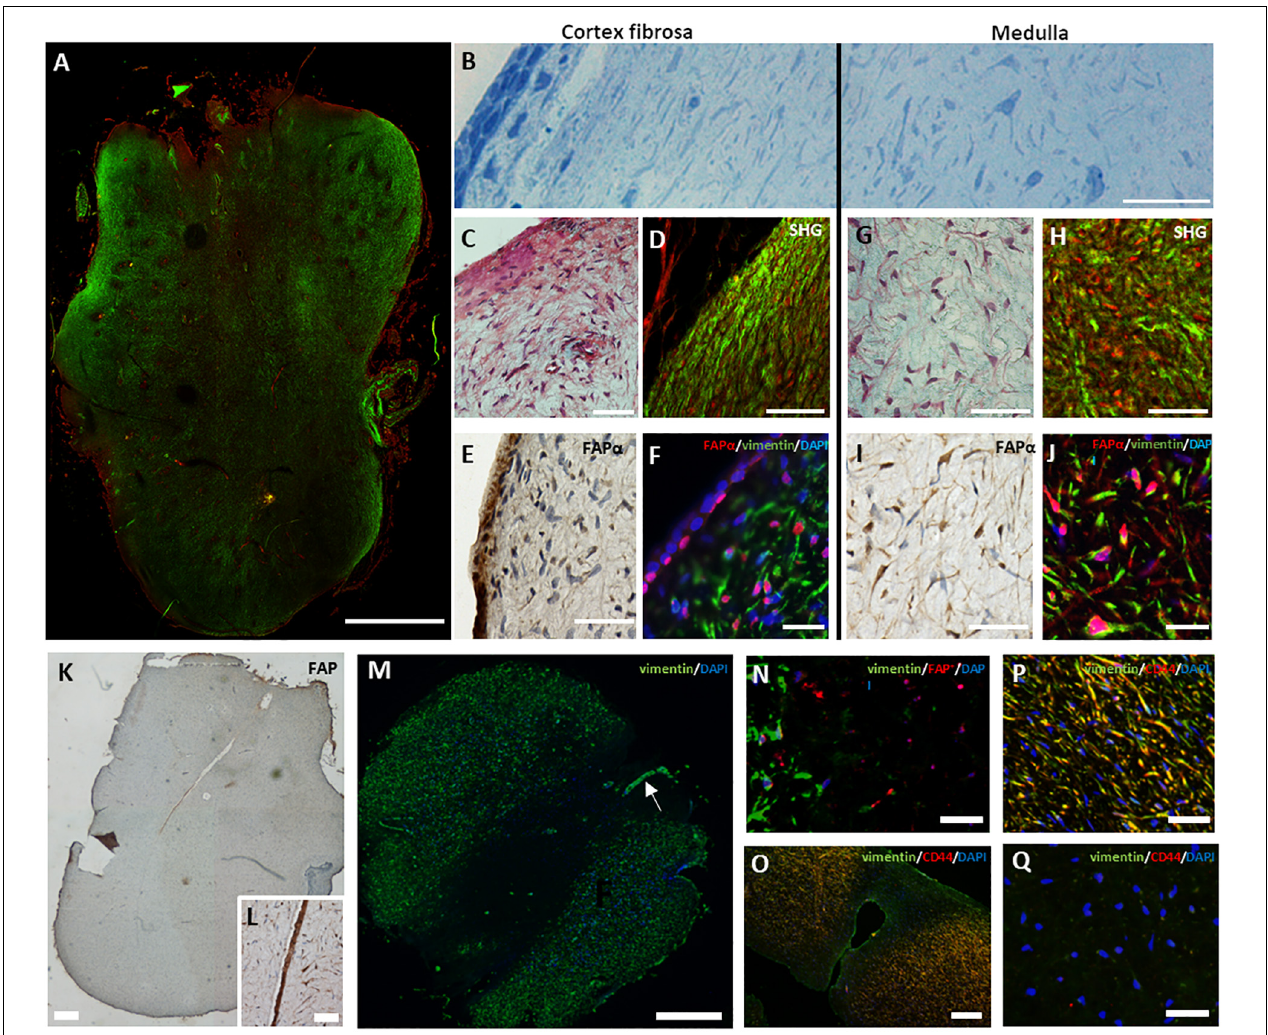
FIGURE 2 | Heterogeneous expression of FAP α in the apical papilla. (A) Tile scan of a second harmonic generated overview of a complete apical papilla (green, collagen type I; red, autofluorescence). (B) Semi-thin section of an apical papilla stained with toluidine blue showing a parallel orientation of cells at the cortex fibrosa but random orientation inside the medulla. (C) Masson’s Trichrome staining of the cortex fibrosa showing a high collagen concentration. (D) Second harmonic generation imaging of the periphery of the apical papilla (green, collagen type I; red, autofluorescence). (E) DAB staining for FAP α reveals a heterogeneous expression pattern at the periphery of the tissue. Note the marked staining of FAP α in the epithelial region. (F) Double immunofluorescent staining showing predominantly vimentin positive cells (green) and a small population of FAP α + (red)/vimentin + cells. The epithelial region consists of FAP α + but vimentin − cells. (G) Masson’s Trichrome staining of the medulla reveals a loose extracellular matrix with spindle-shaped cells. (H) Second harmonic imaging confirms the loose collagen distribution (green). (I) DAB staining indicates high expression levels of FAP α in the medulla. (J) Immunofluorescent staining reveals a predominant population of FAP α + (red)/vimentin + (green) cells. (K) FAP α expression in the dental nerve ( K , magnification in L ). (M) Immunofluorescent staining showing absence of vimentin staining in the inner medulla. Note the presence of the vimentin positive nerve ( M , arrow). (N) Double immunofluorescent staining showing vimentin negative but FAP α positive cells (red) in the inner medulla. (O–Q) Double immunofluorescent staining of vimentin (green) and CD44 (red) reveals double positive cells in the outer medulla (yellow) but complete absence of staining in the inner medulla. Scale bars represent 25 (F,J,O,P,Q,N) , 50 (B,C,D,E,G,H,I,L) , 100 (J) , 250 (K,M) , and 1000 (A) µ m.